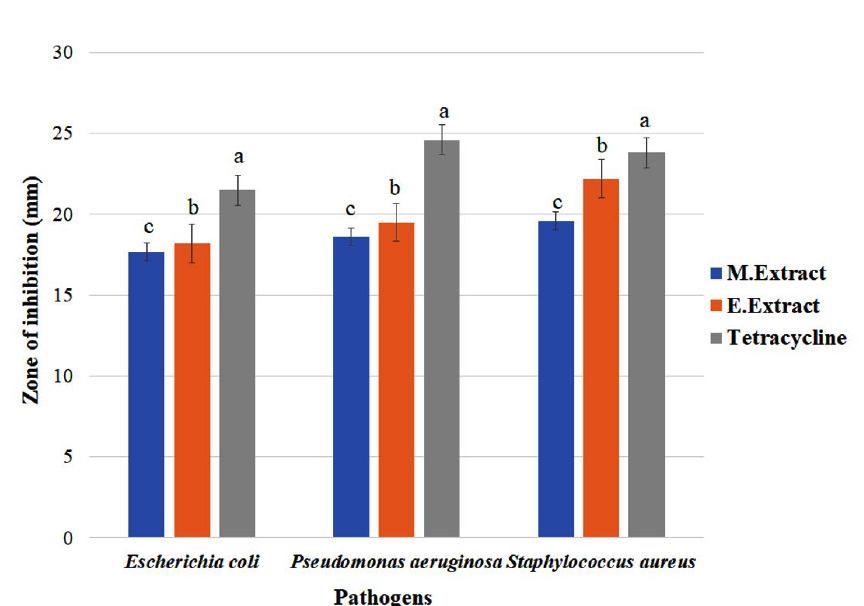
Fig. 6. Comparative analysis of zone of inhibition by Streptobacillus sp. crude extract obtained in different solvents against pathogens. (Results are expressed as means of three replicates and vertical bars indicate standard deviations of the means. Different letters indicate significant differences among the results according to Duncan’s multiple range test at P ≤